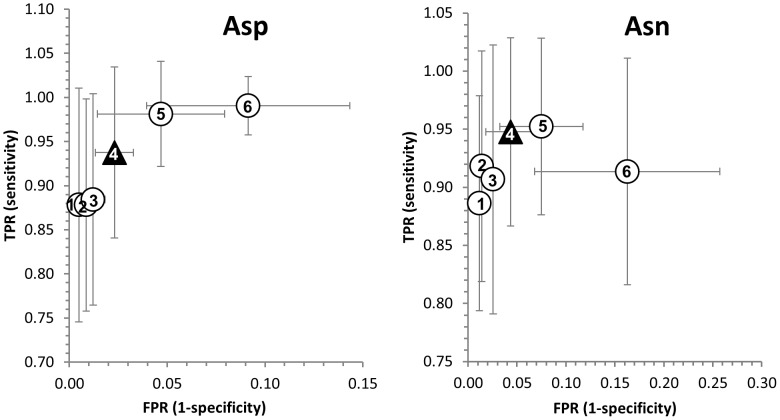
ROC plot for comparison of different pruning levels of decision trees.Decision trees were pruned automatically as implemented in Pipeline Pilot. Average numbers of false-positive and false-negative Asn/Asp residues are results of 40 rounds of Monte Carlo cross validation. TPR (true positive rate)  =  number of true positives divided by number of positives. FPR (false positive rate)  =  number of false positives divided by number of negatives. Trees 1-3 and 5-6 are shown as spheres, tree 4 as a black triangle. Tree 1 is the un-pruned tree model. Tree 4 was selected for prediction.